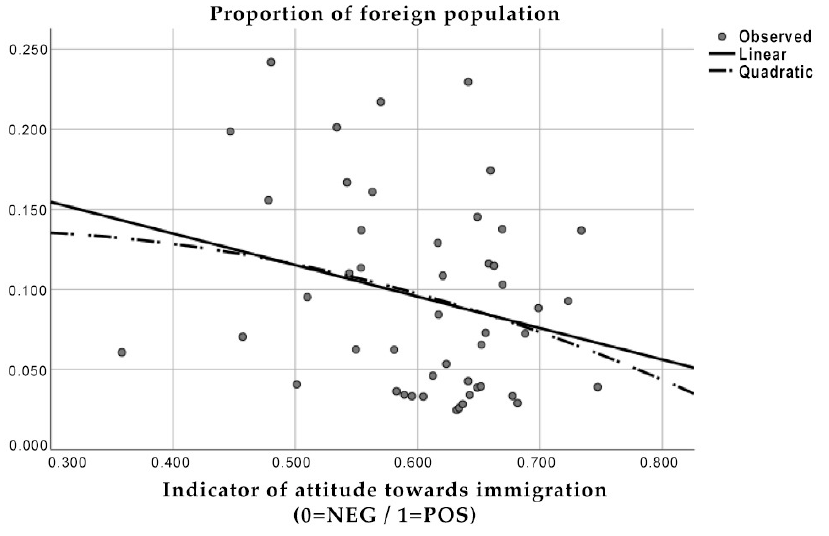
Figure 3. Scatter plot. Correlation between the proportion of foreign population in Spain and the attitude towards immigration. Own elaboration.